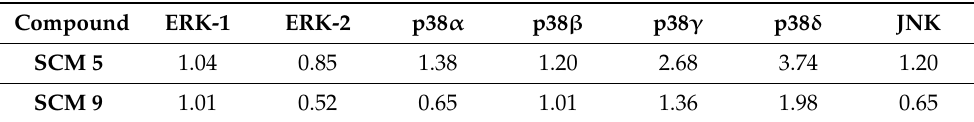
Table 6. E ff ect of SCM compounds on MAP kinase expression in WEHI 231 cells. For description see Table 5 legend. Compound